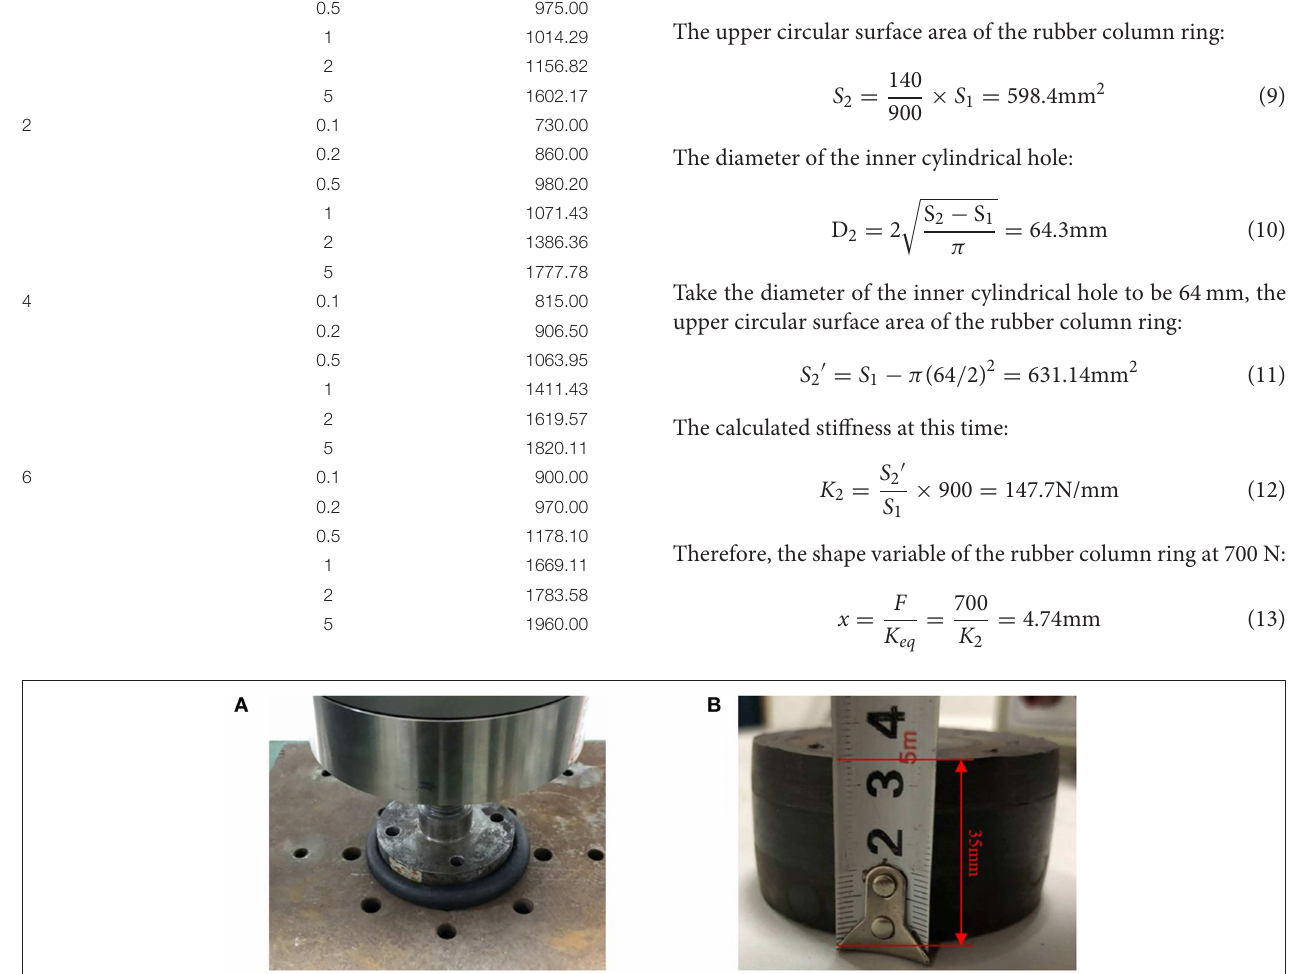
FIGURE 9 | Viscoelastic rubber column compression and recovery deformation test. (A) Deformation at amplitude 20mm and frequency 1Hz. (B) Deformation recovery capability after unloading.